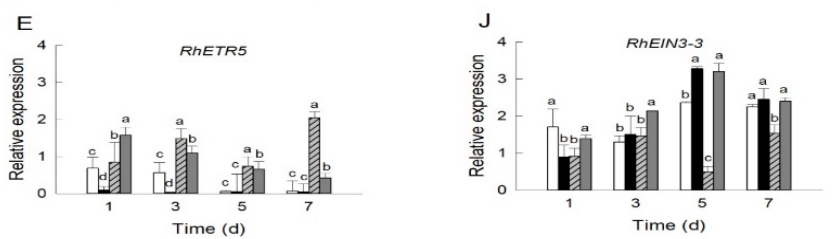
Figure 3. Effect of B. cinerea infection on transcript levels of ethylene receptor ( A – E ) and signaling ( F – J ) genes in petals of cut roses. mRNA levels of ethylene receptor and signaling genes were detected on days 1, 3, 5, and 7 after the transport simulation. NT, non-treated flowers; CON, flowers were held in distilled water; NS and SA, cut flowers were treated with nano silver and salicylic acid. CON, NS, and SA flowers were sprayed with B. cinerea conidial suspension to induce gray mold development. All flowers were then stored at 10 ± 2 °C and 80–90% RH in dark conditions for 4 d for export simulation. Different letters above bars indicate statistically significant differences among treatments at p = 0.05 based on Duncan’s multiple range test. Vertical bars show standard errors of the means ( n = 3).